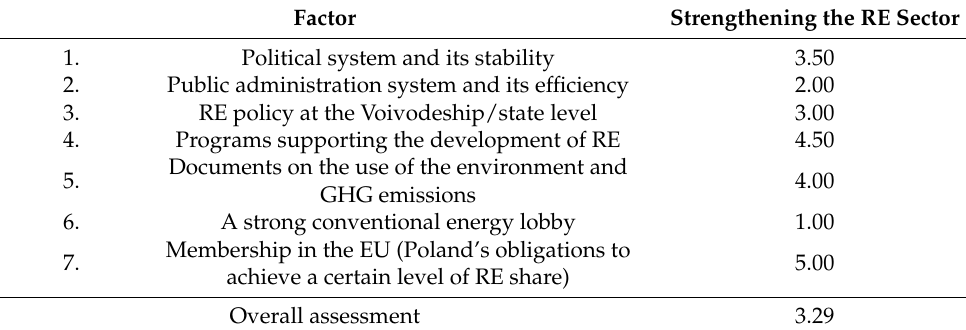
Table 1. The political environment of RE sources in the Pomerania Voivodeship (author’s own